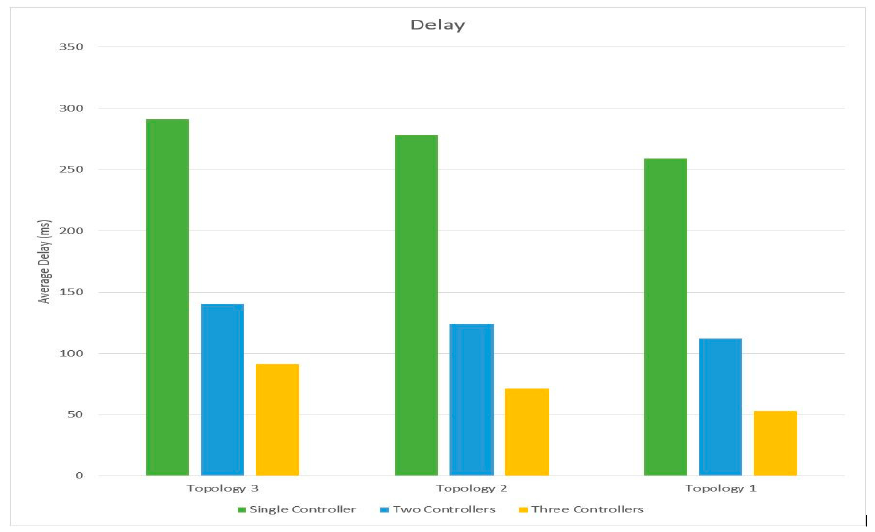
Figure 9. Network delay.